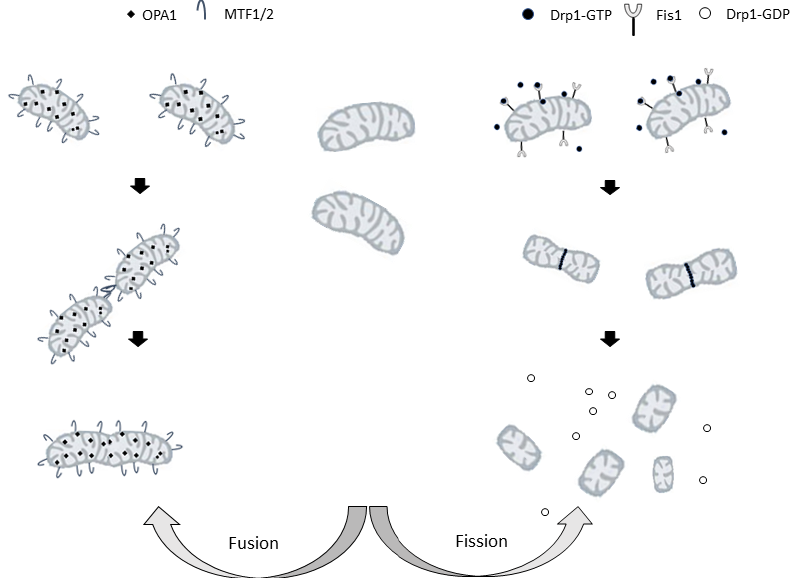
Figure 2. Representation of the mitochondrial fusion (on the left) and fission (on the right) processes. Drp1: cytosolic dynamin-related protein 1; FIS1: mitochondrial fission protein 1. MFN1 / 2: mitofusin 1 or 2; OPA1 optic atrophy factor 1.